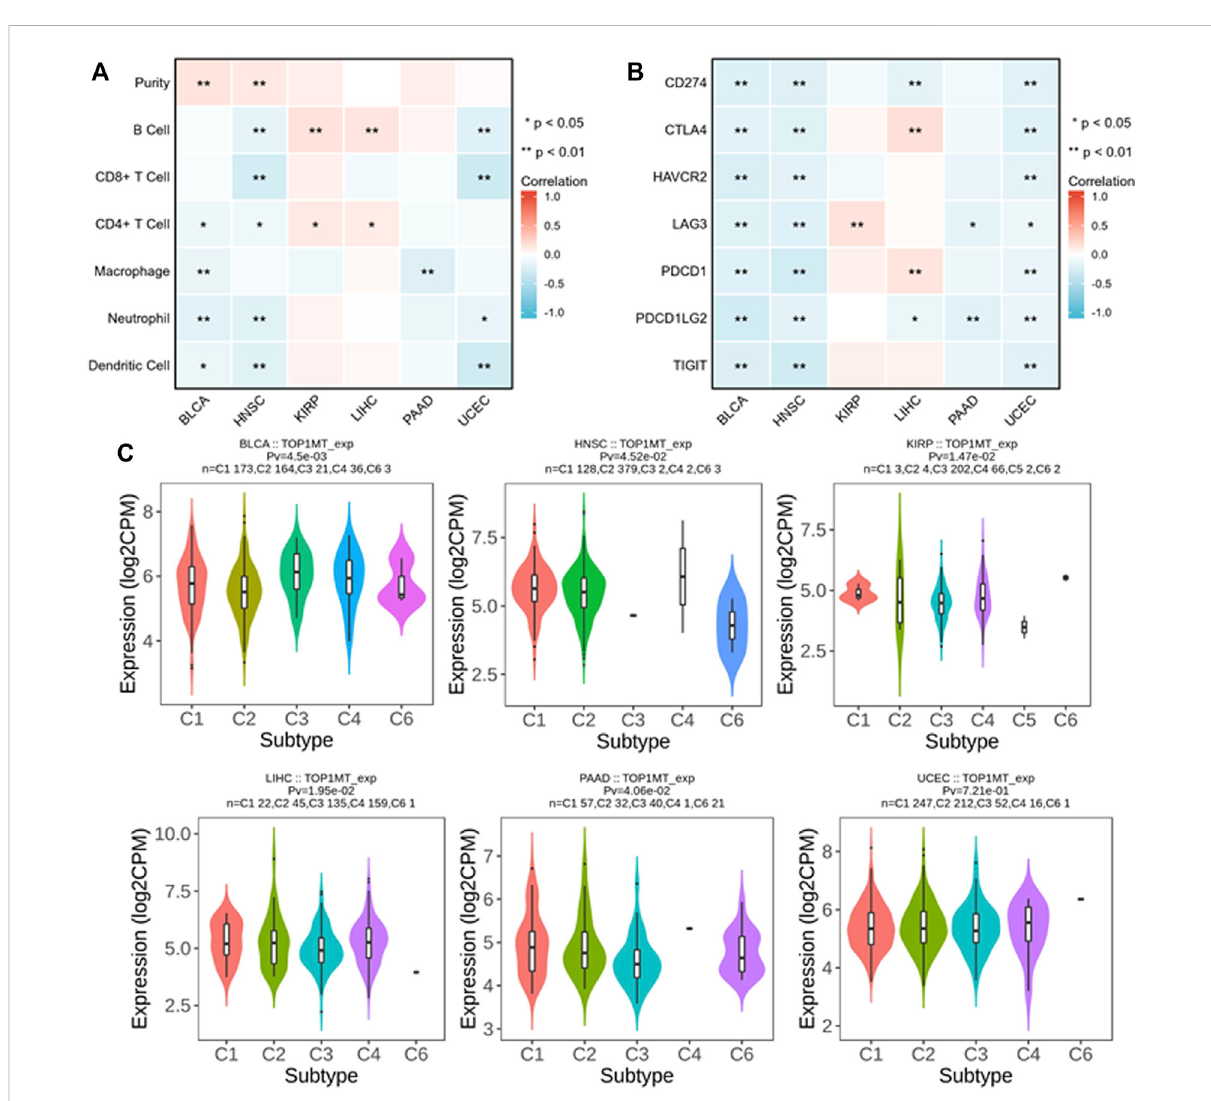
FIGURE 7 Correlation analysis between TOP1MT expression and tumor immune invasion. (A) TOP1MT expression signi fi cantly correlates with in fi ltration level of various immune cells in the TIMER database; (B) TOP1MT expression signi fi cantly correlates with various immune checkpoints in the TIMER database; (C) TOP1MT expression in different molecular subtypes of cancer by TISIDB. p p < 0.05, pp p < 0.01 and pp p <